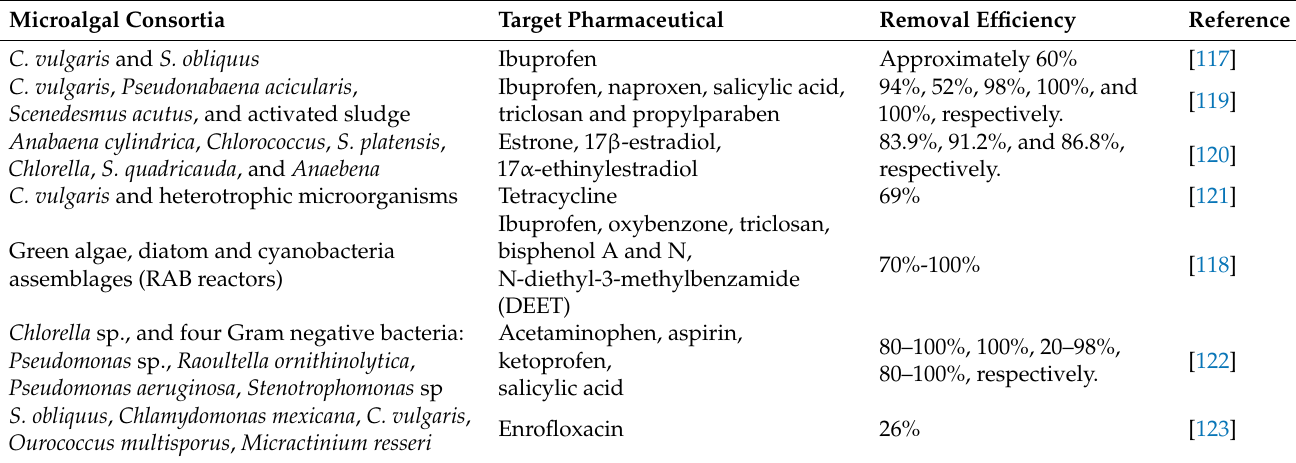
Table 5. Microalgal consortia for PPCP